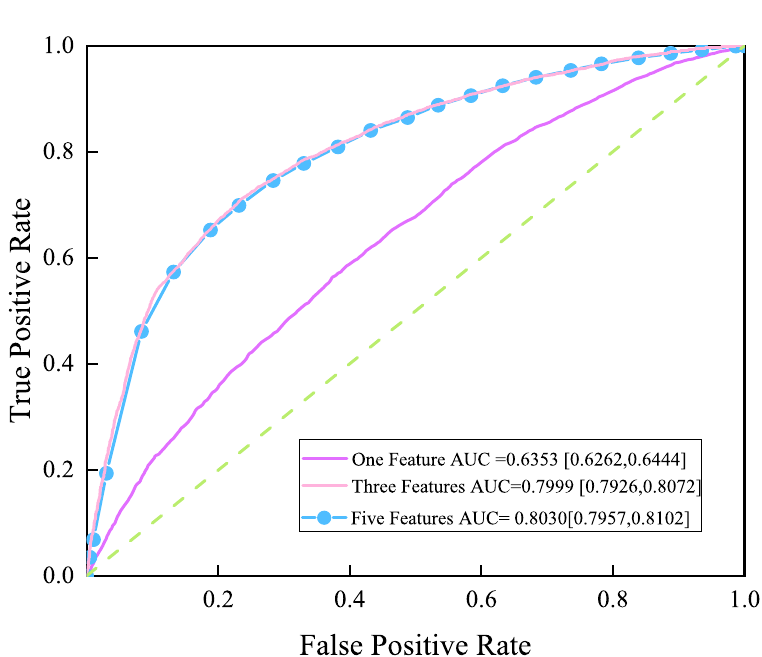
Figure 1. ROC curve.One feature(ap_hi), Three features(ap_hi, chol,age), Five features(ap_hi, chol,age,